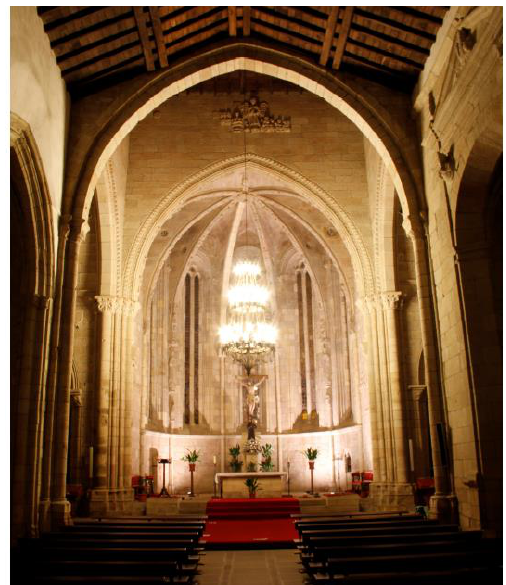
Figure 2. Lighting conditions. San Francisco church settings.